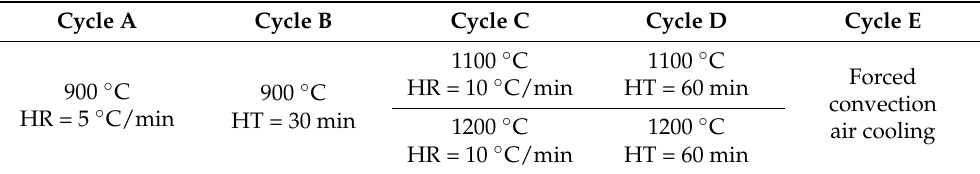
Figure 1. Tablet samples: ( a ) after pressing and ( b ) after clinkering. Table 2. Details of the pre-calcination and clinkering thermal cycles.